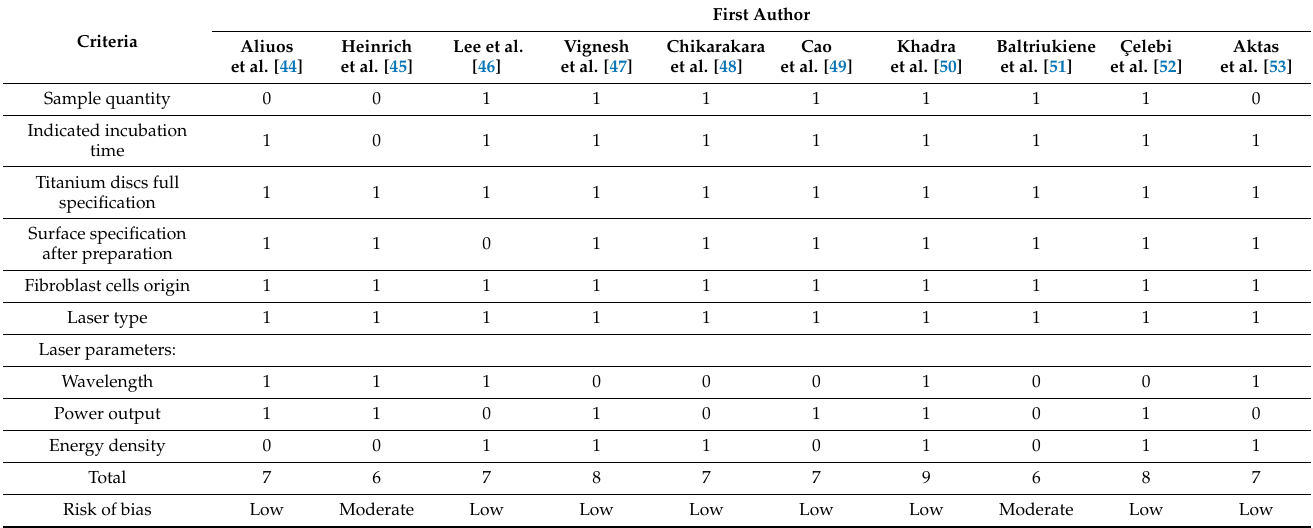
Table 5. Quality assessment of the included